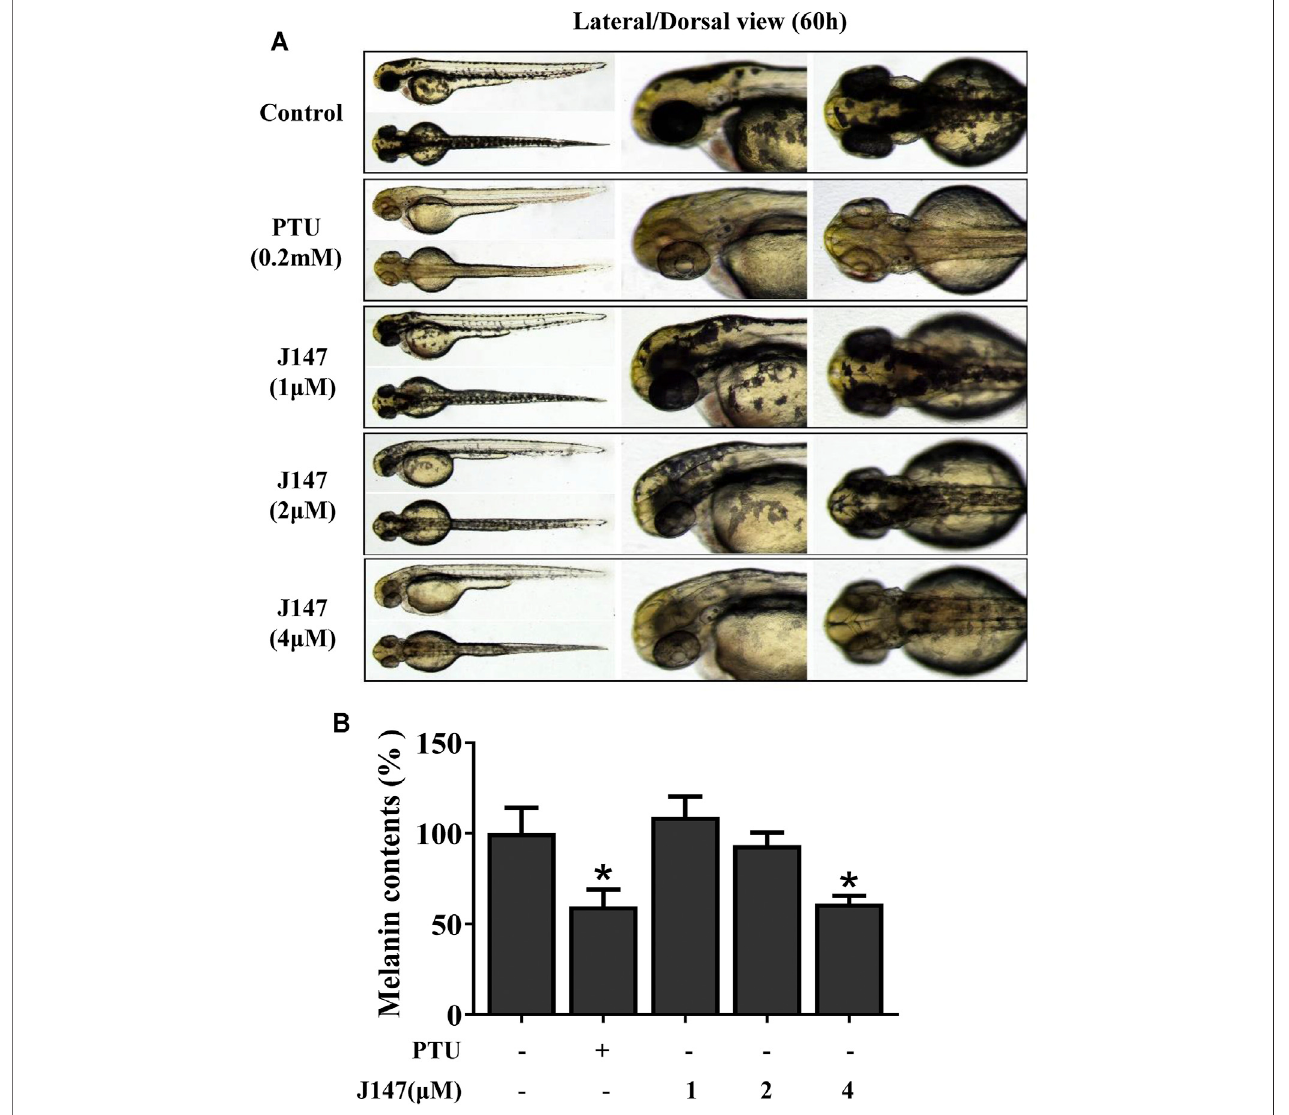
FIGURE7| EffectofJ147onpigmentationinzebra fi sh. (A) Representativephotographsofzebra fi sh.Zebra fi shembryosweretreatedwithPTUorJ147from35to 60 h. Theeffectson thepigmentation ofzebra fi sh wereobserved under thestereomicroscope. (B) About100 embryos were collected and dissolved in lysisbuffer. After centrifugation,melaninpigmentwasdissolvedin500 μ LofNaOHworkingsolution(1 mol/L,10%DMSO)at80 ° Cfor1 h,andtheabsorbancewasmeasuredat405 nm.